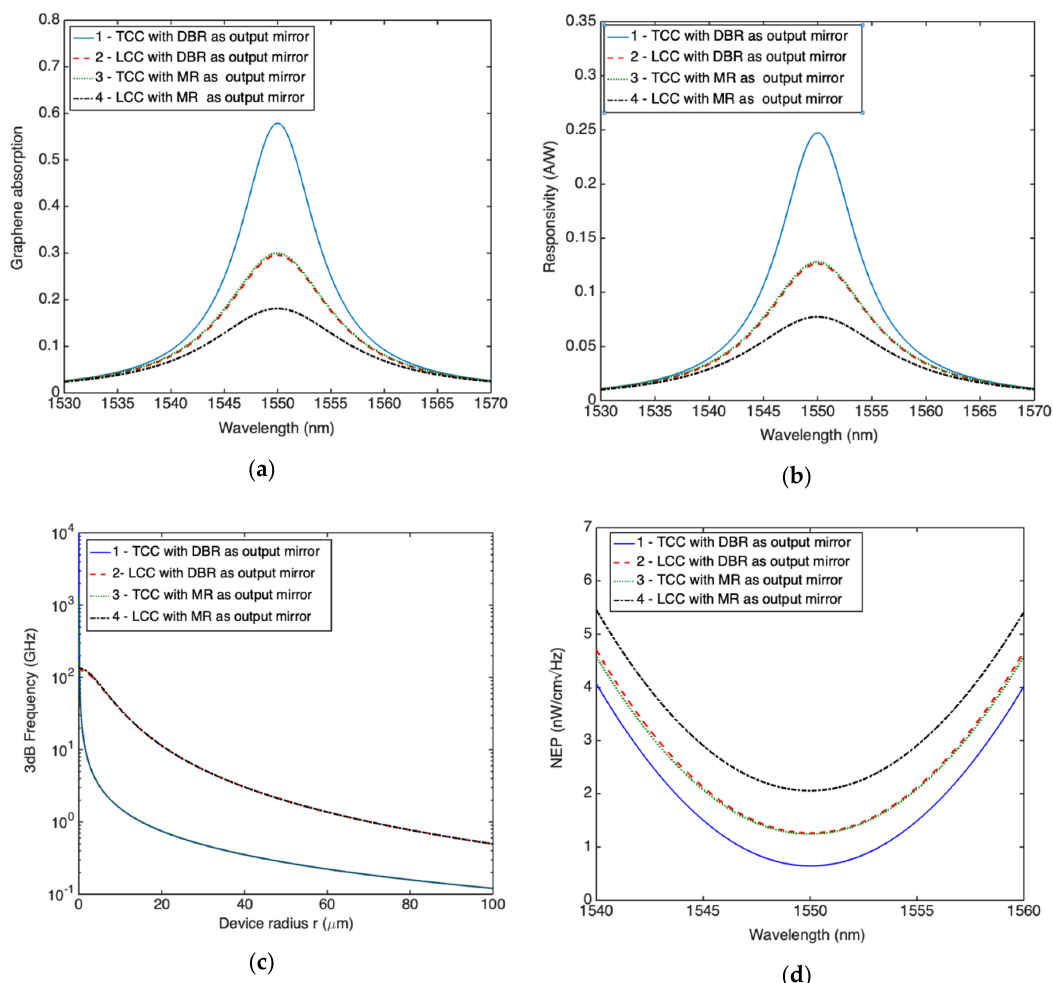
Figure 12. Comparison between optimized TCC and LCC Fabry-Pérot graphene/Si Schottky PDs provided of both DBR and MR as output mirror in term of: ( a ) spectral graphene absorption, ( b ) spectral responsivity, ( c ) 3 dB frequency and ( d ) spectral NEP.